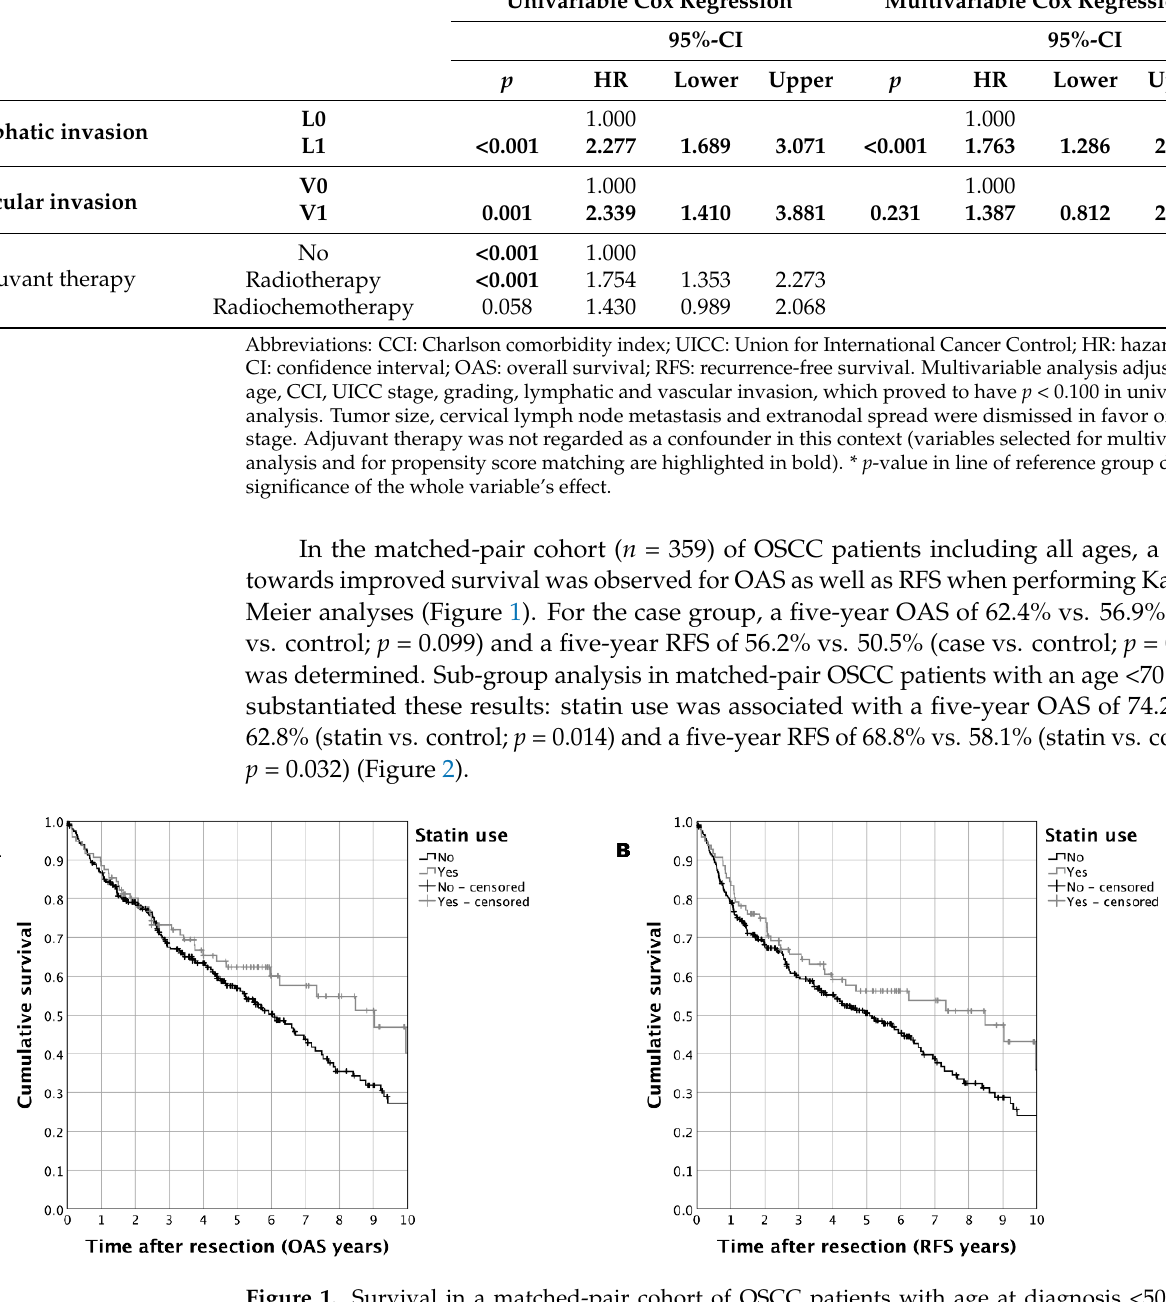
Figure 1. Survival in a matched-pair cohort of OSCC patients with age at diagnosis <50 years ( n = 359) comparing patients taking statins to those patients without statin treatment: ( A ): Kaplan–Meier analysis for OAS ( p = 0.099); ( B ): Kaplan–Meier analysis for RFS ( p = 0.074).